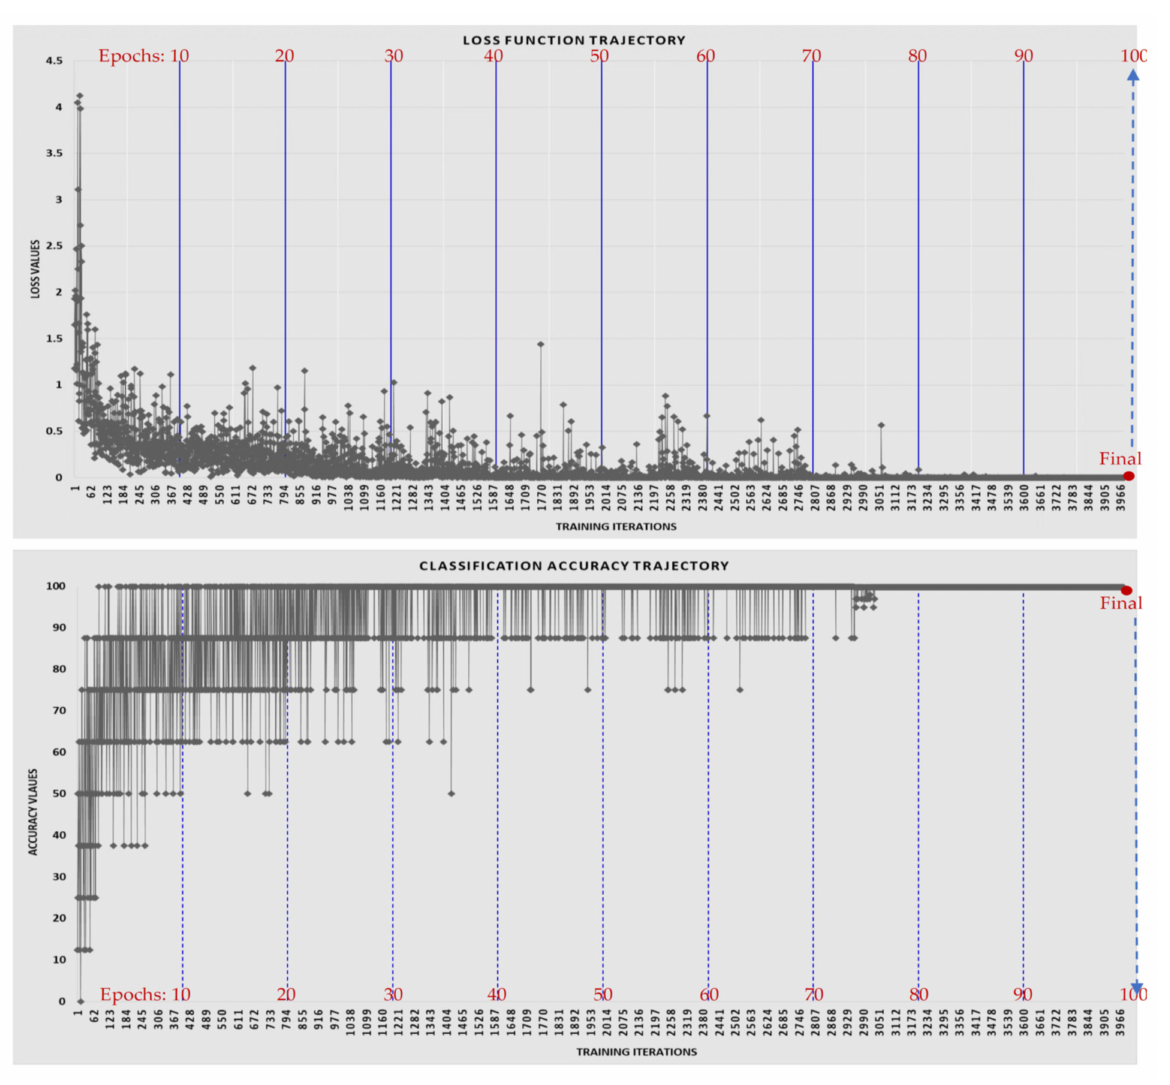
Figure 9. Loss function trajectory vs. classification accuracy trajectory for 100-epochs training using SGD solver